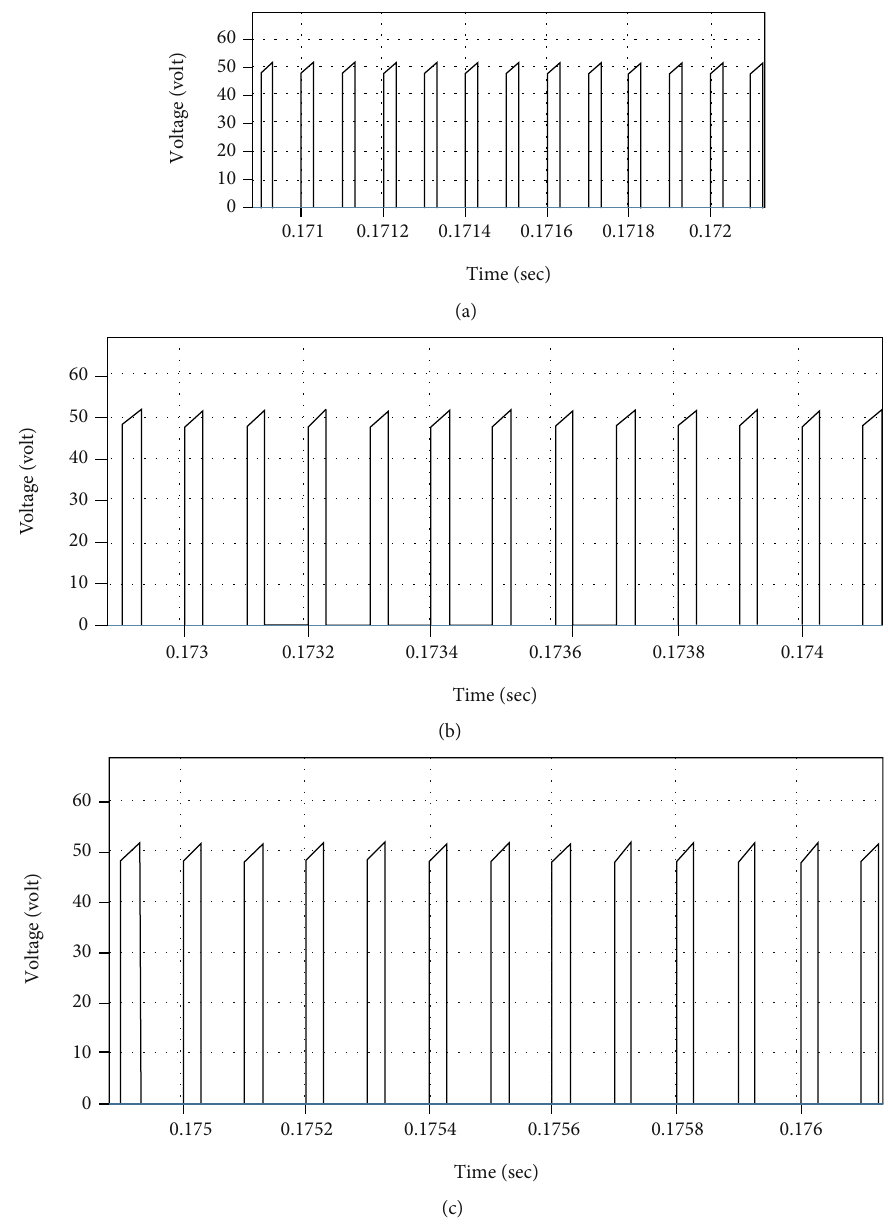
Figure 9: (a) Voltage stress across M